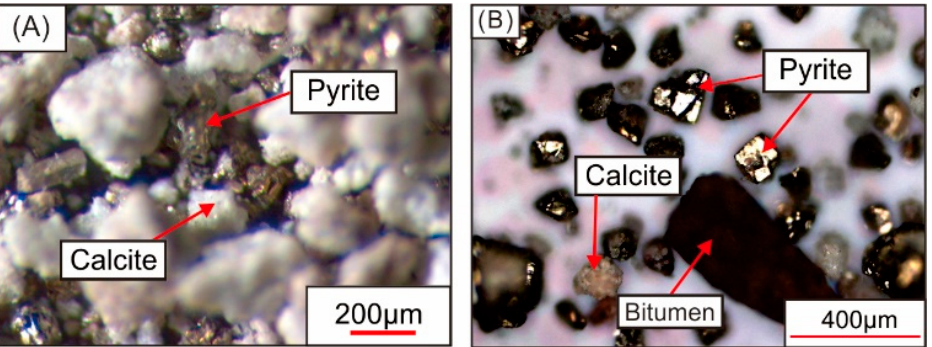
Figure 3. Typical stereo binocular microscope photomicrographs (reflective light) show that pyrites are disseminated in the samples and coexist with calcites in specimen A ( A ), with bitumen are found to coexist with pyrite and calcite in specimen B ( B ).